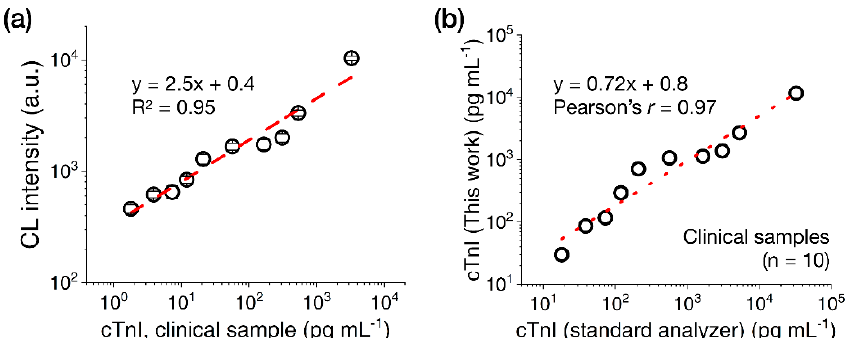
Figure 6. Results of cTnI clinical sample testing with the LFA. ( a ) Test results obtained with cTnI clinical serum samples (n = 10). ( b ) Correlation between the measured cTnI concentration in clinical samples found using the 15 nm AuNP-(ald)HRP-Ab conjugate and standard analyzer. All data shown in ( a ) represent the mean ± SD (n = 3). The cTnI levels indicated in (a) reflect the final concentrations used in the assays. The cTnI levels indicated in ( b ) represent the initial concentrations of the samples.